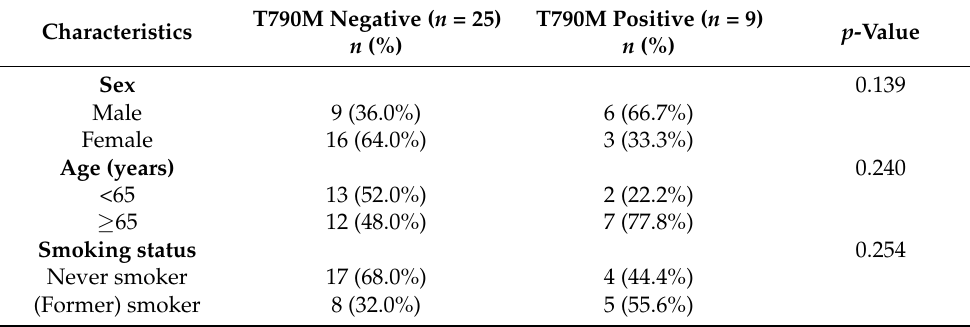
Table 1. Patient’s characteristics according to the presence of EGFR -Thr790Met.